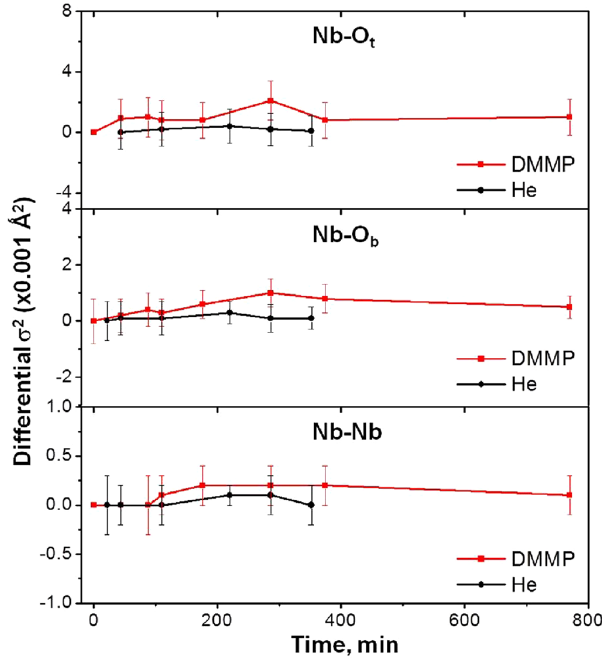
Figure 3. Differential bond distance disorder ( σ 2 ), as obtained from quantitative analysis of in situ Nb K-edge EXAFS data, as a function of DMMP/ He feed during interaction of DMMP with CsPONb for ( a ) Nb-O terminal , ( b ) Nb-O bridging and ( c ) Nb-Nb bonds in CsPONb